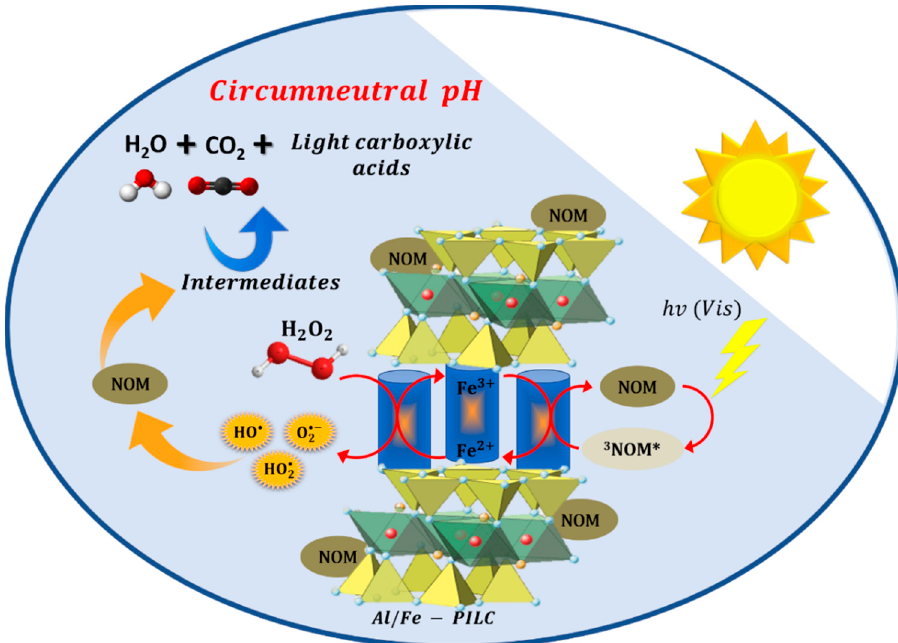
Figure 5. Proposed mechanism for the self-promoted visible-light enhanced photocatalytic wet peroxide oxidation of NOM by improved reduction of surface Fe 3+ into Fe 2+ in Al/Fe-pillared clays.